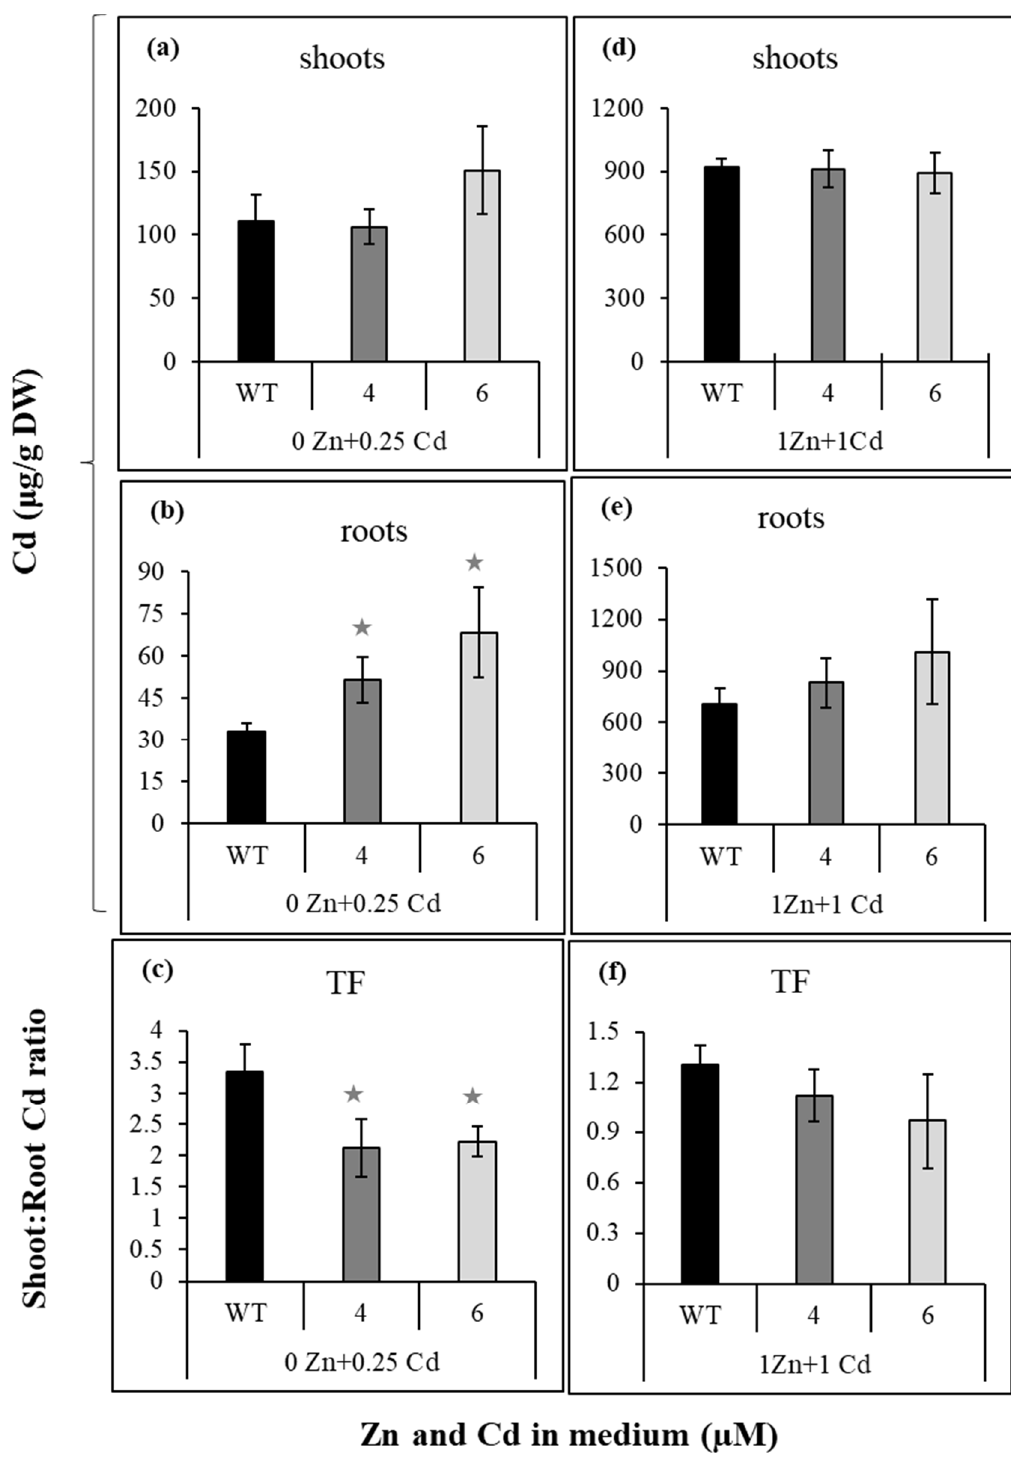
Figure 2. Cadmium concentration in wild-type and NtZIP4A / B -RNAi plants grown under various Zn and Cd concentrations. 3.5-week-old plants of wild-type (WT) and NtZIP4A / B -RNAi lines (number 4 and number 6) grown in the quarter-strength Knop’s medium were exposed for 17 days to the control medium supplemented with pairwise combinations of Zn (0; 1 µ M) and Cd (0; 0.25; 1 µ M) concentrations. Concentrations of cadmium were determined in the shoots ( a , d ), and roots ( b , e ). The Translocation Factor (TF) was determined as the ratio of shoot/root concentrations of Cd ( c , f ). Values correspond to means ± SD ( n = 5); those significantly different from wild-type (WT) (evaluated by Student’s t -test) are indicated by asterisks ( p ≤ 0.05). 2.3. Changes in the Accumulation of Zn and Cd in the Root Parts of NtZIP4A/B-RNAi Plants